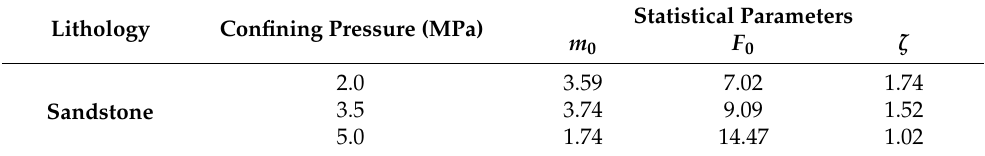
Table 3. WCR damage parameters.